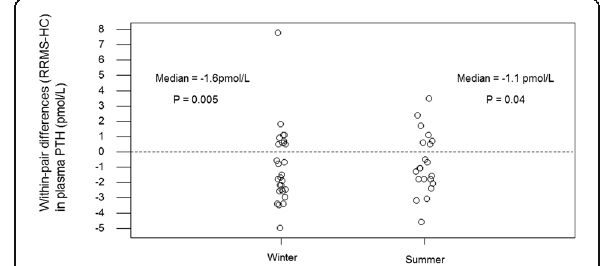
Fig. 2 Within-pair differences (RRMS-HC) in plasma